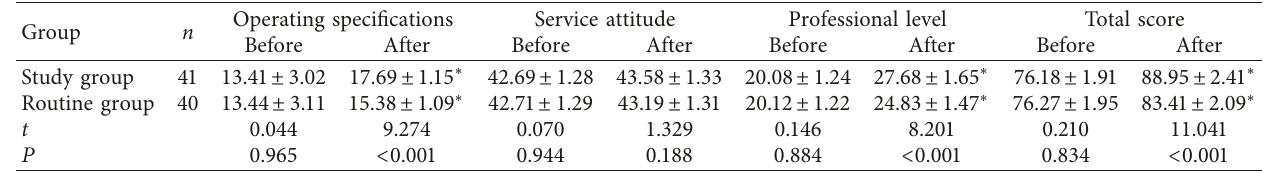
Table 4: Comparison of NSNS scores between the two groups ( x ± s ,